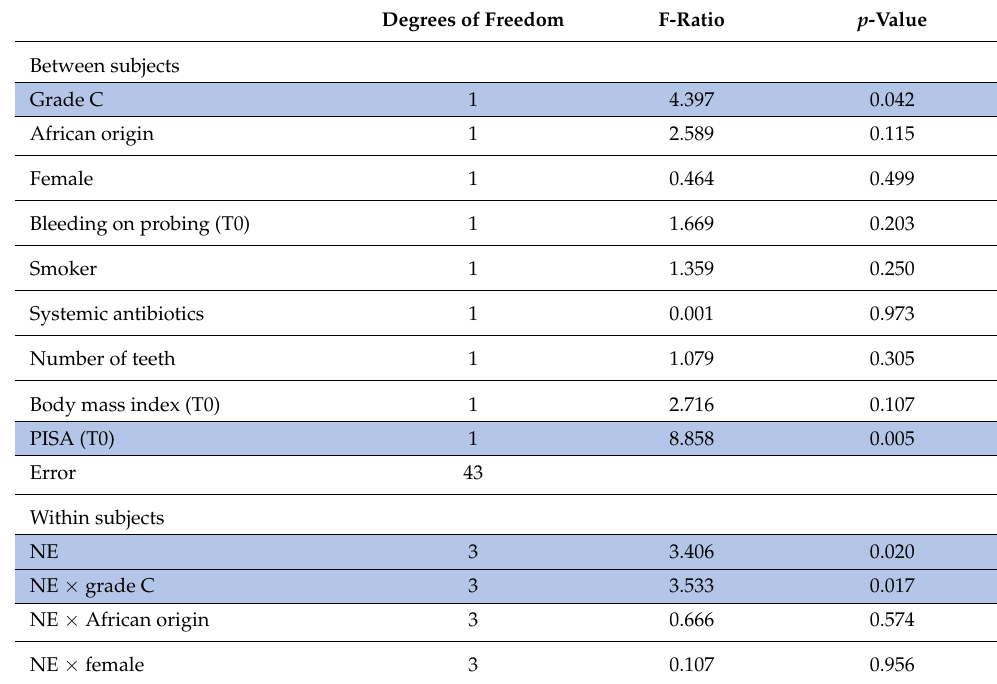
Table 4. Repeated measures analysis of variance of log-transformed neutrophil elastase